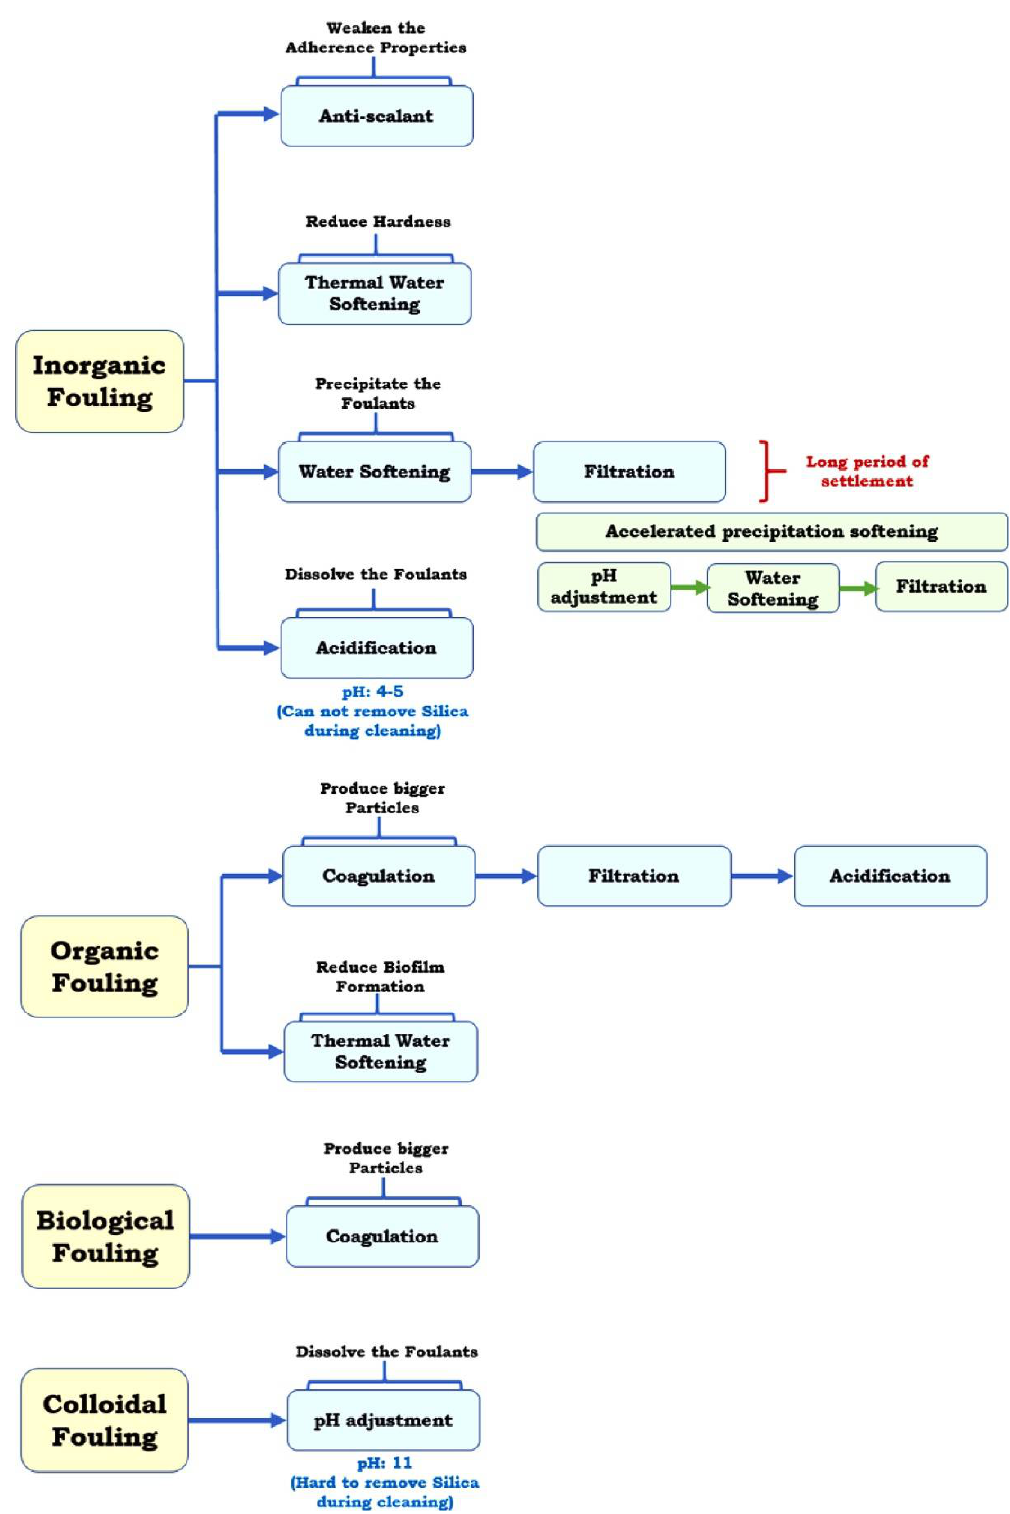
Figure 26. Different pre-treatment methods for various types of fouling in MD [132].